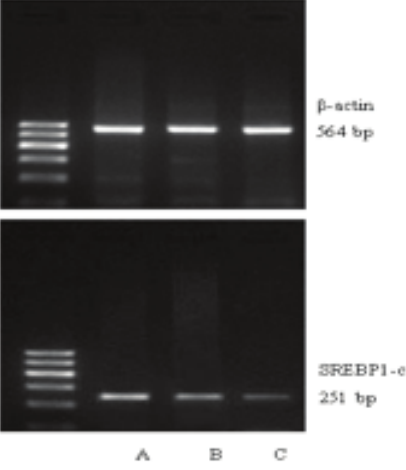
Figure 1: LXRα mRNA expression in placentas of each group (A: severe PE, B: mild PE, C: normal)